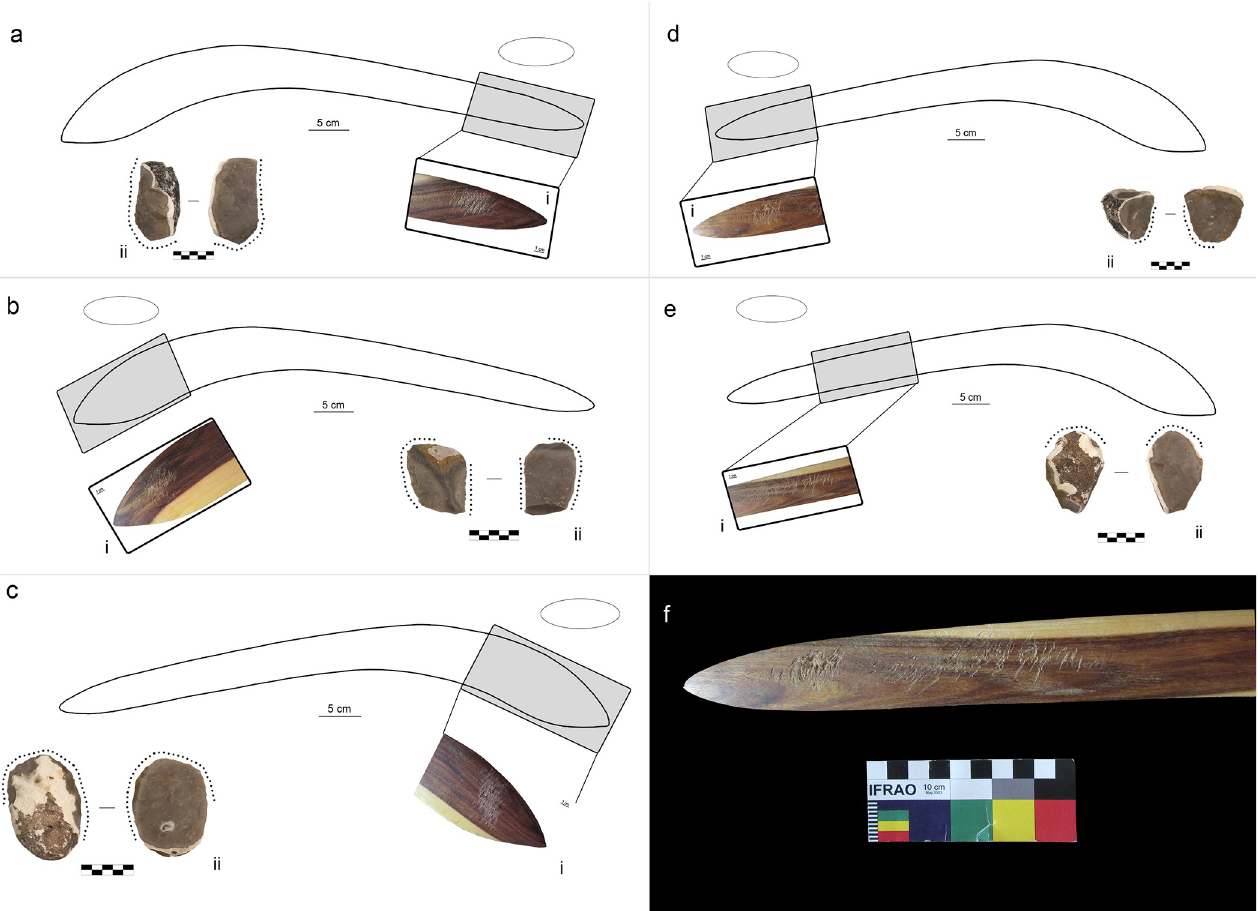
Fig 4. Results of retouching session 2 on the boomerang B3 (bi-convex cross-section and location of use areas). (a) location of use area B3_1, (i) use area B3_1 (1x), (ii) retouched flake F36; (b) location of use area B3_4, (i) use area B3_4 (1x), (ii) retouched flake F76; (c) location of use area B3_5, (i) use area B3_5 (1x), (ii) retouched flake F40. (d) location of use area B3_2, (i) use area B3_2 (1x), (ii) retouched flake F73; (e) location of use area B3_3, (i) use area B3_3 (1x), (ii) retouched flake F03; (f) adjacent use areas B3_2 and B3_3.